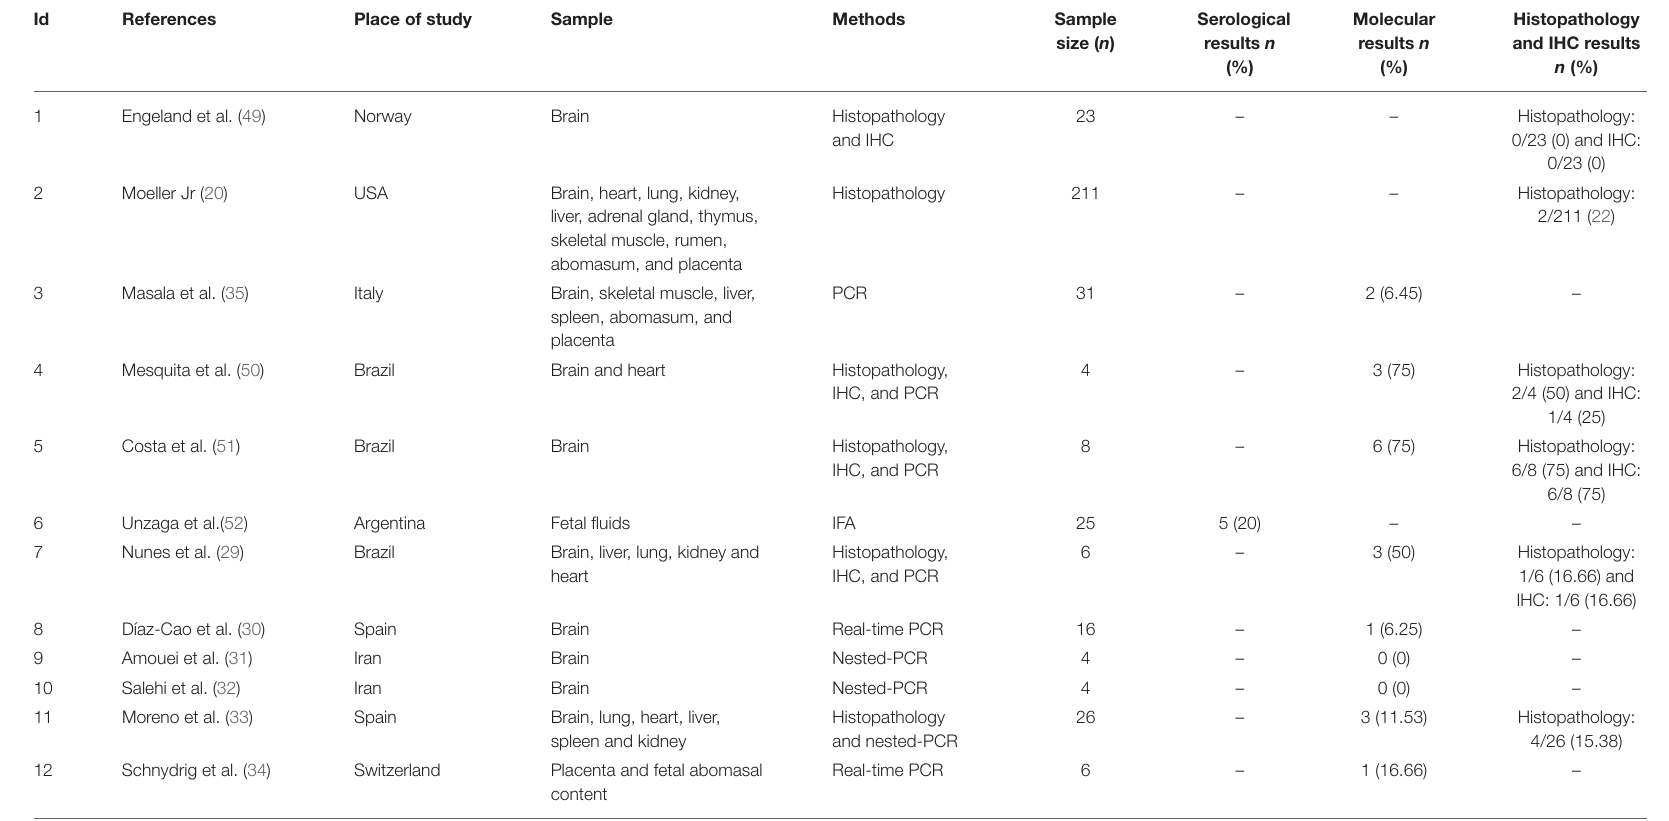
TABLE 3 | Characteristics of the included studies for prevalence of N. caninum in the aborted fetuses of